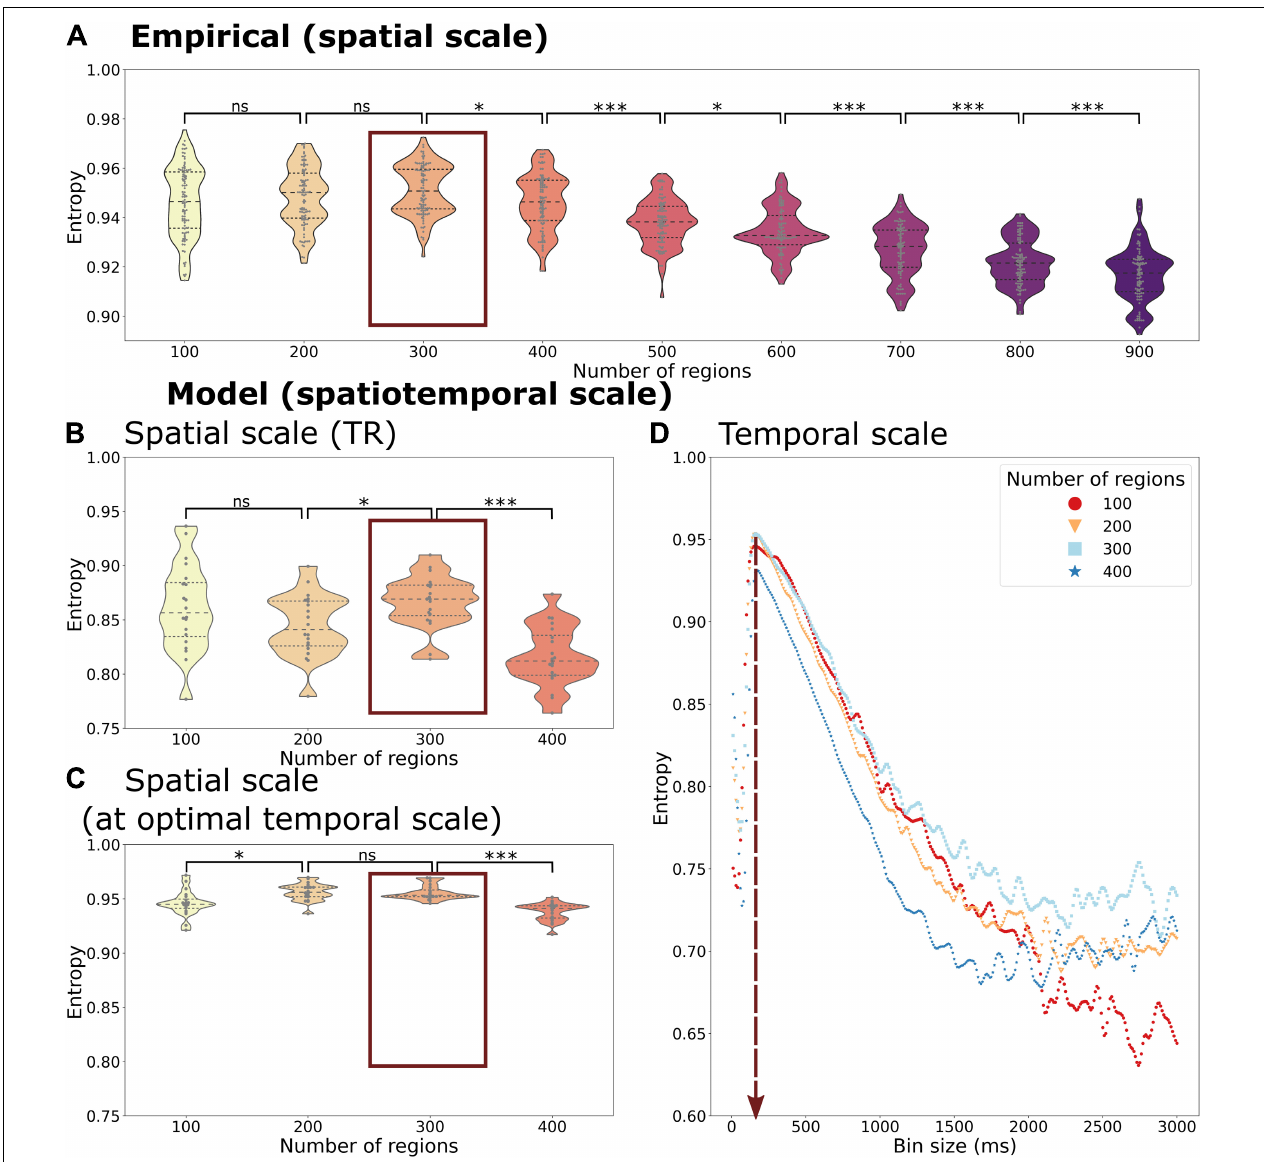
FIGURE 4 | Entropy of the temporal probability of whole-brain functional networks in different spatial and temporal scales of the empirical (A) and simulated data (B–D) . The entropy is calculated across spatial scales in the empirical data with a fixed temporal scale of 720 ms (corresponding to the TR). The simulated data gives the opportunity to explore different spatial scales at the temporal scale of the TR, 720 ms, (B) as well as at the optimal temporal scale of 150 ms (C) . Beyond that it can be also used to explore various temporal scales and spatial scales simultaneously (C) . Both the empirical and simulated data show that the highest entropy can be found at a spatial scale of 300 regions with only a minor decrease in entropy at a spatial scale of 200 regions (marked by a red box in A–C ). The highest entropy can be found at a temporal scale of 150 ms across all spatial scales (vertical red arrow in D ). Each datapoint depicts a random group of 10 subjects in the empirical data or a simulation trial simulating a group of 10 subjects. Statistical significance of comparisons between spatial scales is indicated with “ns” meaning a p > 0.05, * meaning < 0.05, *** meaning 0.001